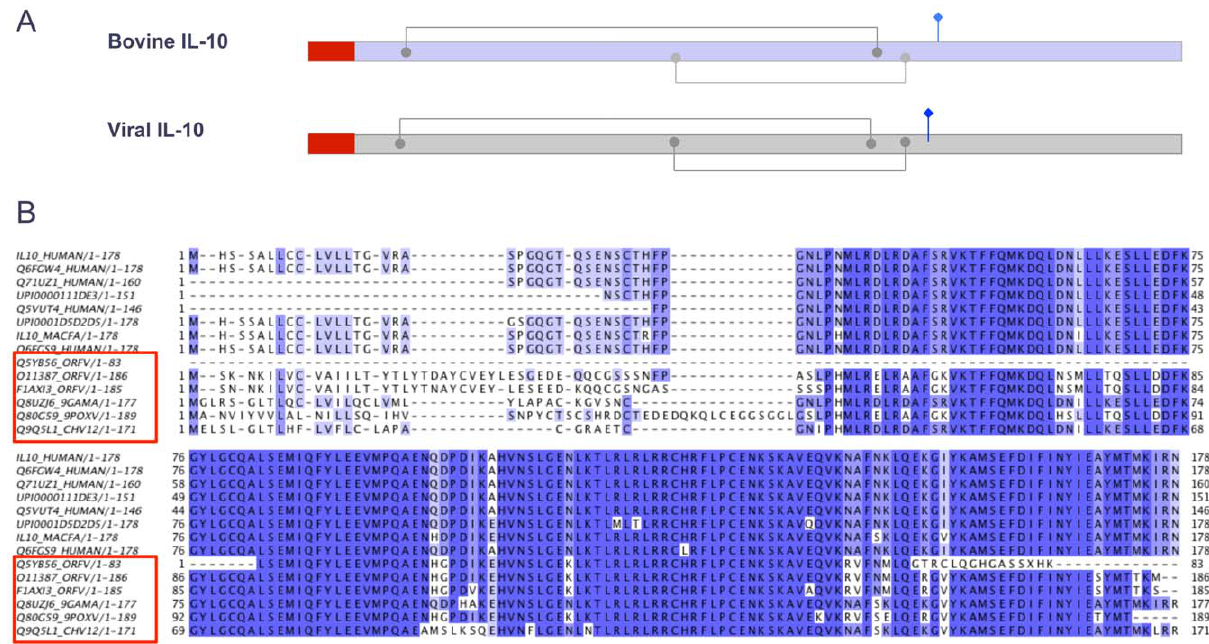
Figure 2. Multiple sequence alignment for Interlukin-10 (IL-10). ( A ) Functional features of human IL-10 include the disulfide bridges, glycosylated modified residues (blue, diamond line) and the signal peptide (red frame). Most viral proteins in the cluster share the 180 amino acid proteins. ( B ) Multiple sequence alignments (MSA) from viral representatives (red frame) and various mammals are shown. The viral proteins include Orf virus (ORFV), Macacine herpesvirus 4 (Rhesus lymphocryptovirus), Bovine papular stomatitis virus and Cercopithecine herpesvirus 12 (CeHV-12) (Baboon herpesvirus). Weak sequence similarity is confined to the N-terminal that covers the signal peptide.